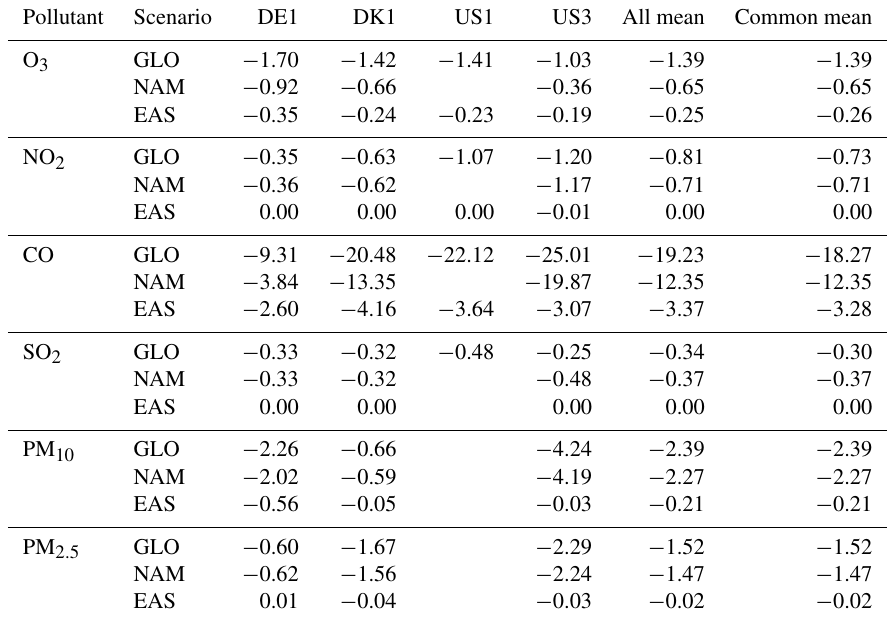
Table 5. Annual mean absolute differences (ppb for gases and µgm − 3 for particles) between the base case and the different emission perturbation scenarios as calculated by the different model groups over the North American domain.